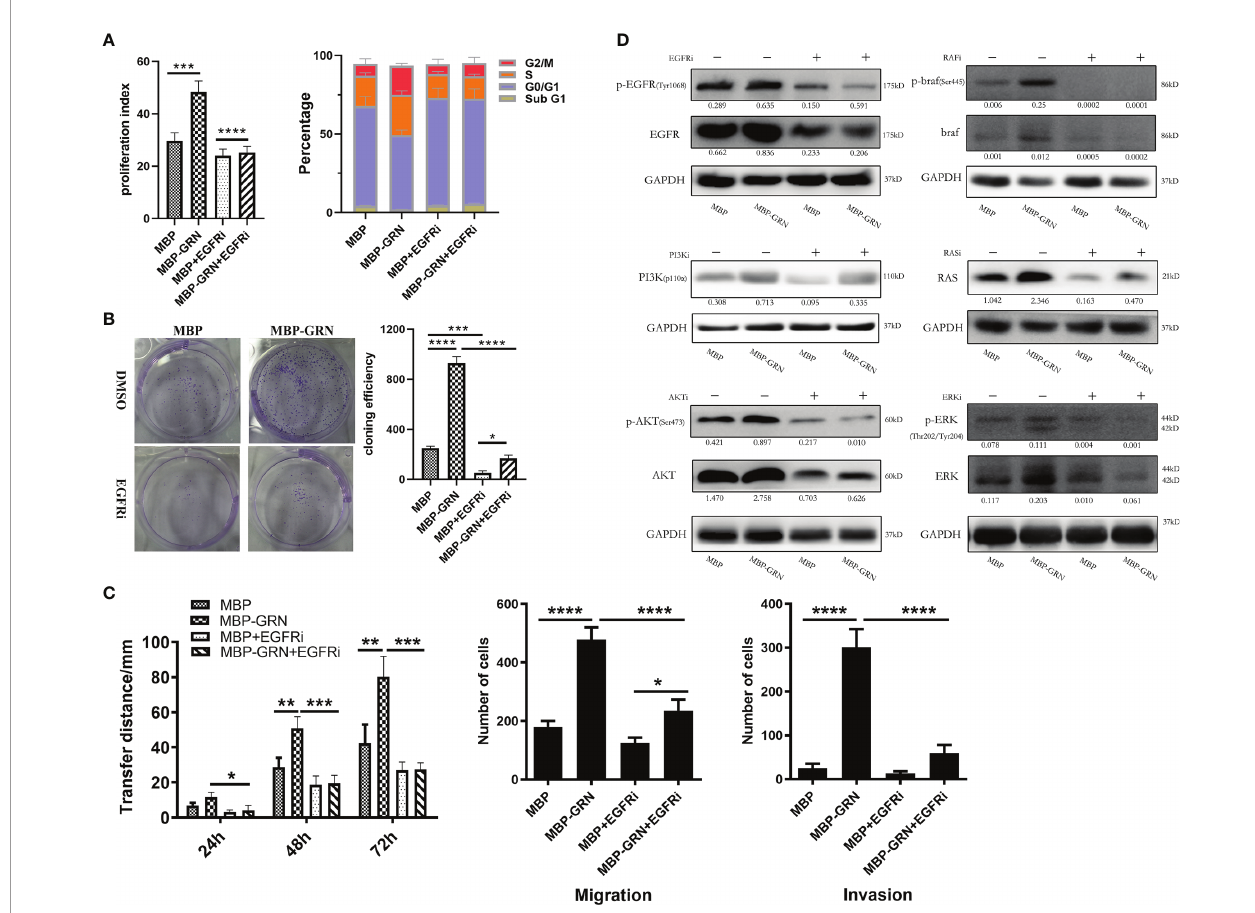
FIGURE 7 | The effects and changes of RAS/MAPK/ERK and PI3K/Akt signaling pathways in LO2 cells after co-cultured with recombinant Cs GRN protein and EGFR inhibitor. (A) The histogram of PI and the percentage of cell cycle phase. (B) The representative images from colony formation assay and histogram of cloning ef fi ciency. (C) The migration and invasion of LO2 cells were explored by wound healing scratch assay and Transwell assay. (D) The protein expression of RAS/ MAPK/ERK and PI3K/Akt signaling pathways in LO2 cells after treated with recombinant Cs GRN protein and inhibitors. Quanti fi cation of protein was measured by Image J and showed under each band. * P < 0.05 versus control group, ** P < 0.01 versus control group, *** P < 0.001 versus control group, **** P < 0.0001 versus control